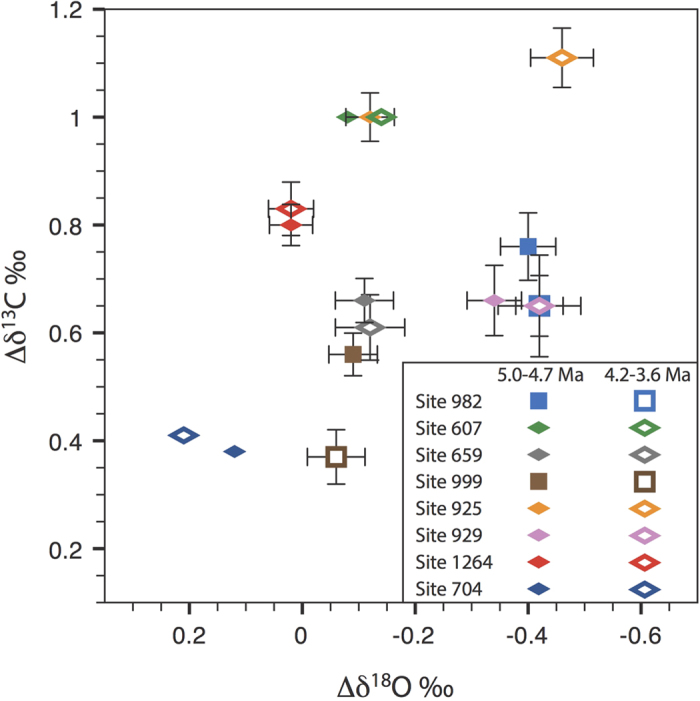
Average δ13C and δ18O values (both plotted in ‰ vs Vienna Pee Dee Belemnite) for the time slice intervals 5.0–4.7 Ma (Pre CAS shoaling) and 4.2–3.6 Ma (Post CAS shoaling) plotted as anomalies with respect to changes at Pacific Site 849 (see text).Square symbols indicate sites recording ocean water masses at intermediate depths (1000–2000 m) while diamond symbols indicate sites recording water masses in the deep ocean (>2000 m). Error bars are 2σ combined error on the difference, Due to poor time resolution for Site 704 and lack of original time series data for Site 607, no error bars are shown for these sites. Note that errors serve only as an indication of the confidence in mean values calculated. Data references are given in Table 1.